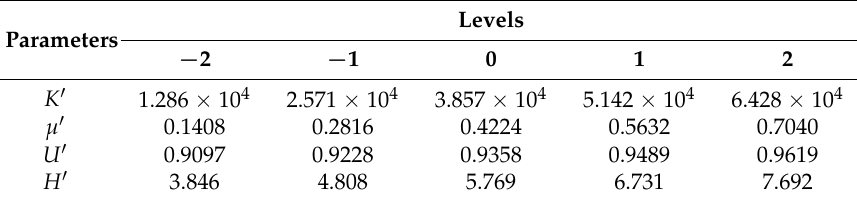
Table 3. Dimensionless parameter values for different